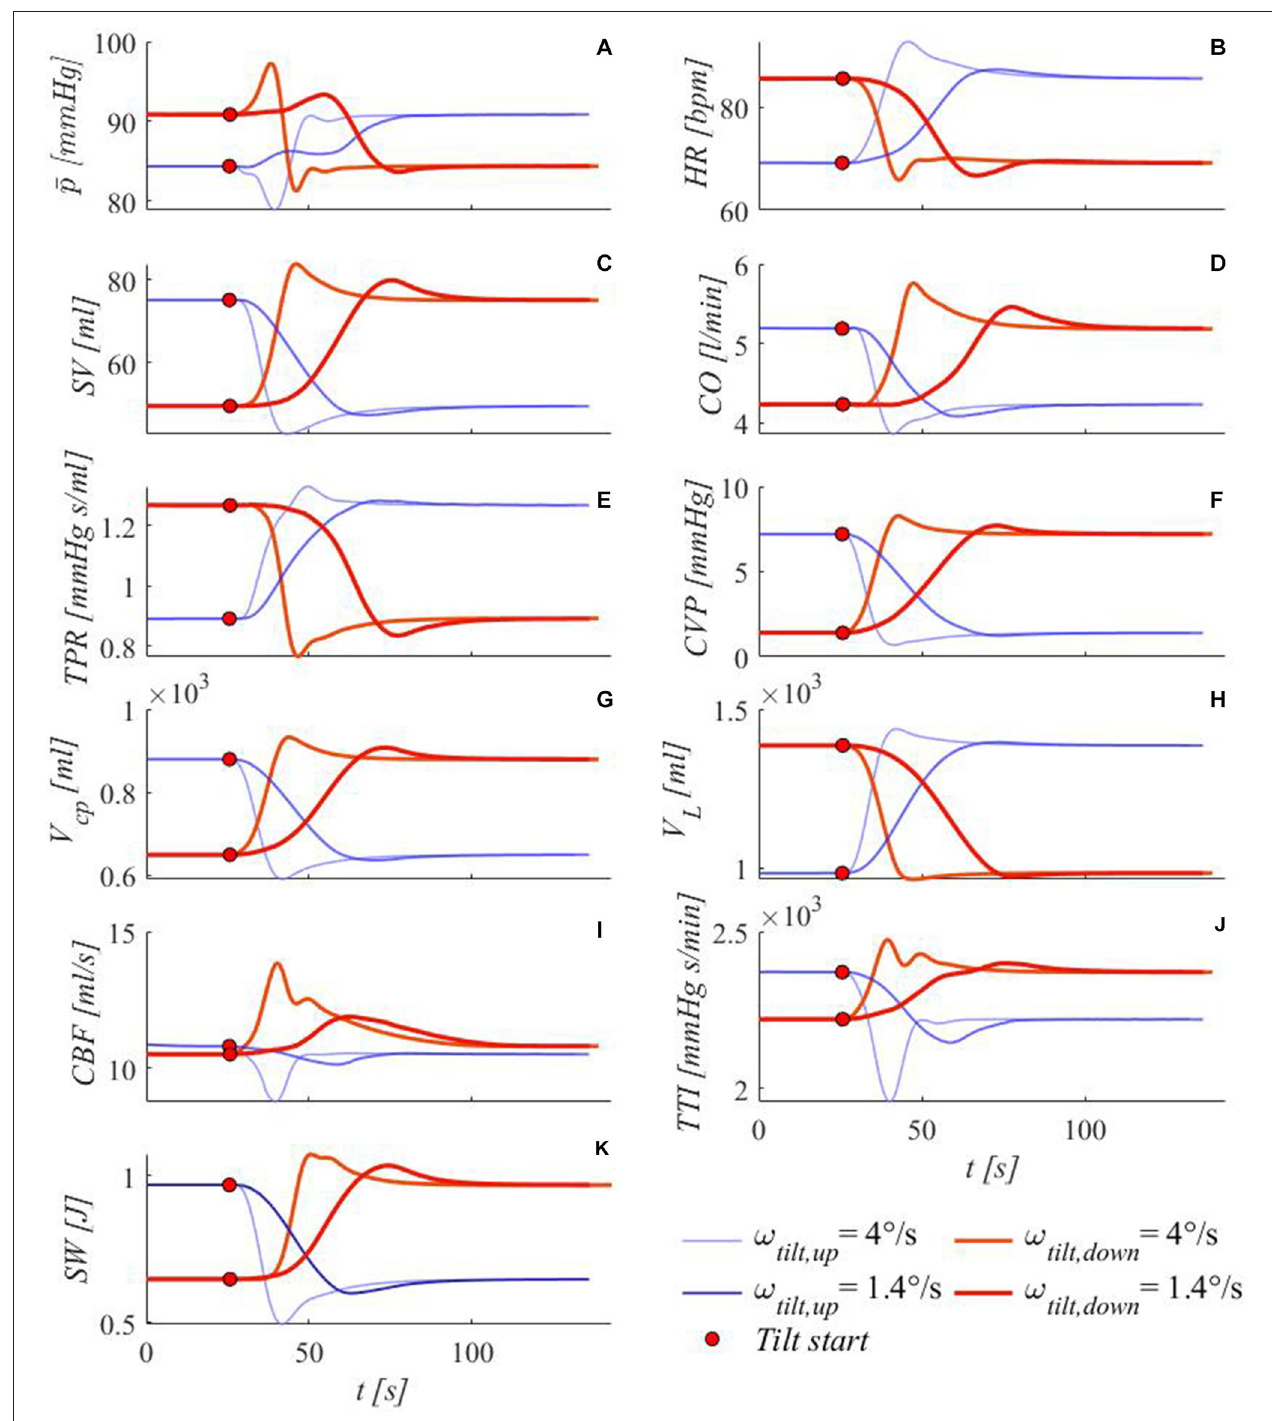
FIGURE 9 | Simulated transient response of some meaningful hemodynamic variables to passive tilt-down from 70 ◦ to the supine position at two different tilting rates (red, thin lines: 4 ◦ /s, thick lines: 1.4 ◦ /s). For the sake of comparison, corresponding tilt-up transients are also reported (blue lines). (A) brachial mean arterial pressure ¯ p , (B) heart rate HR , (C) stroke volume SV , (D) cardiac output CO , (E) total peripheral resistance TPR , (F) central venous pressure CVP (corresponding to right atrial pressure), (G) cardio-pulmonary blood volume V cp (blood volume of arterial and venous pulmonary circulation, plus the four cardiac chambers), (H) legs vascular volume V L (mostly venous blood volume, but also arterial, arteriolar, venular and capillary), (I) cerebral blood flow CBF (overall average blood flow delivered by carotid and vertebral arteries to the brain), (J) tension-time index TTI (product of the mean left ventricle pressure and RR beat duration per minute, TTI is an index of oxygen consumption), (K) stroke work SW (area of the left ventricle pressure-volume loop). Red points mark tilting starting point.